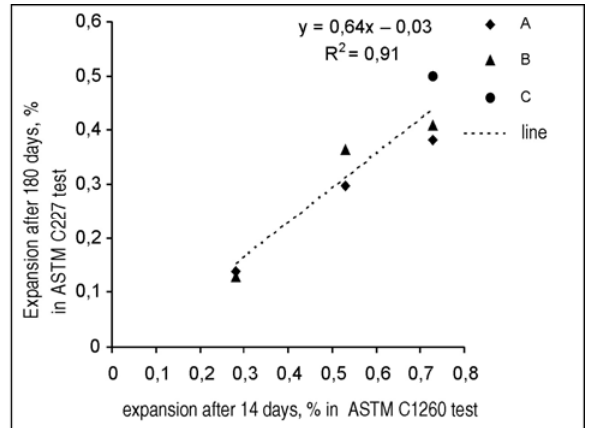
Fig 5. Comparison of the results of ASTM C 227 test and ASTM C 1260 method. A – cement with 0,6 % Na 2 O e , B – cement with 0,9 % Na 2 O e , C – cement with 1,2